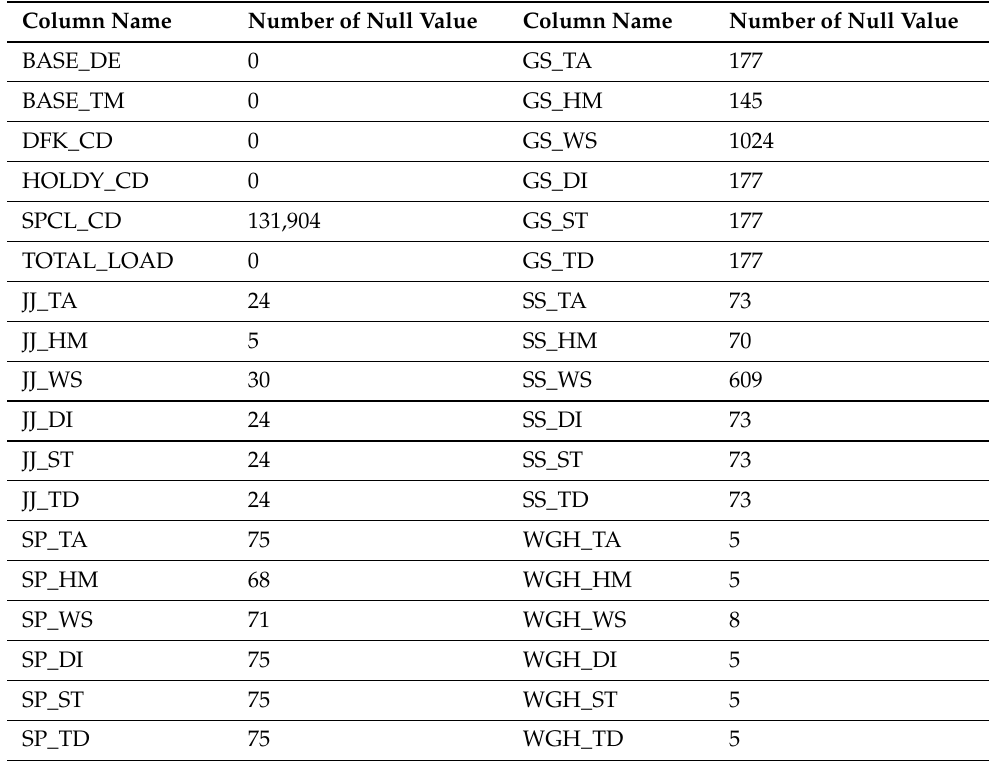
Table 1. Null or missing values in the